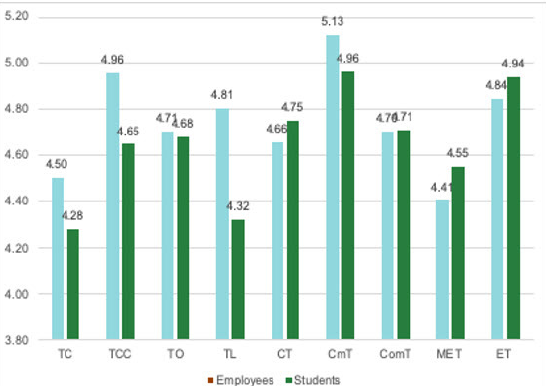
Figure 1. Results of trust in the university community by domains